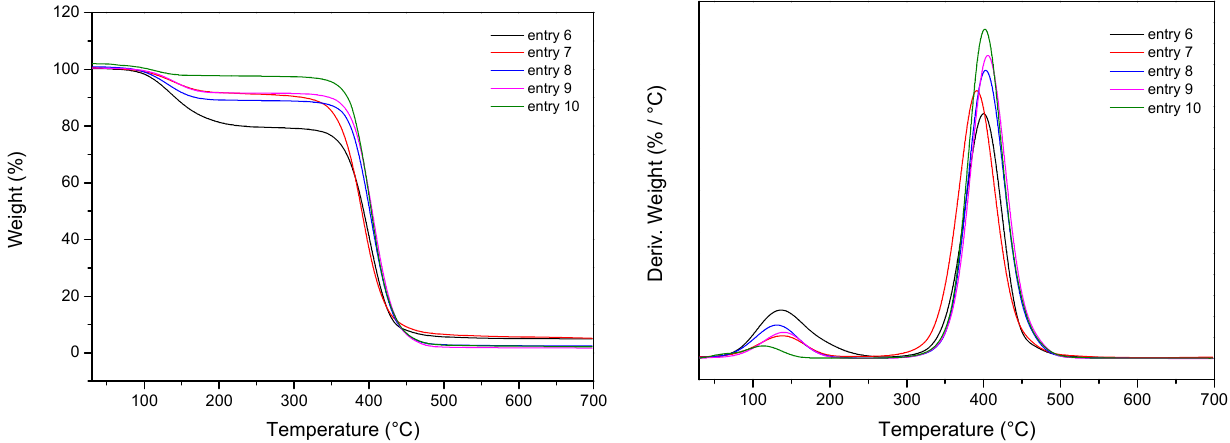
Figure 4. TGA and derivative thermogravimetric (DTGA) curves of TBHM-based linear polyesters (entry 6 to 10 of Table 1).